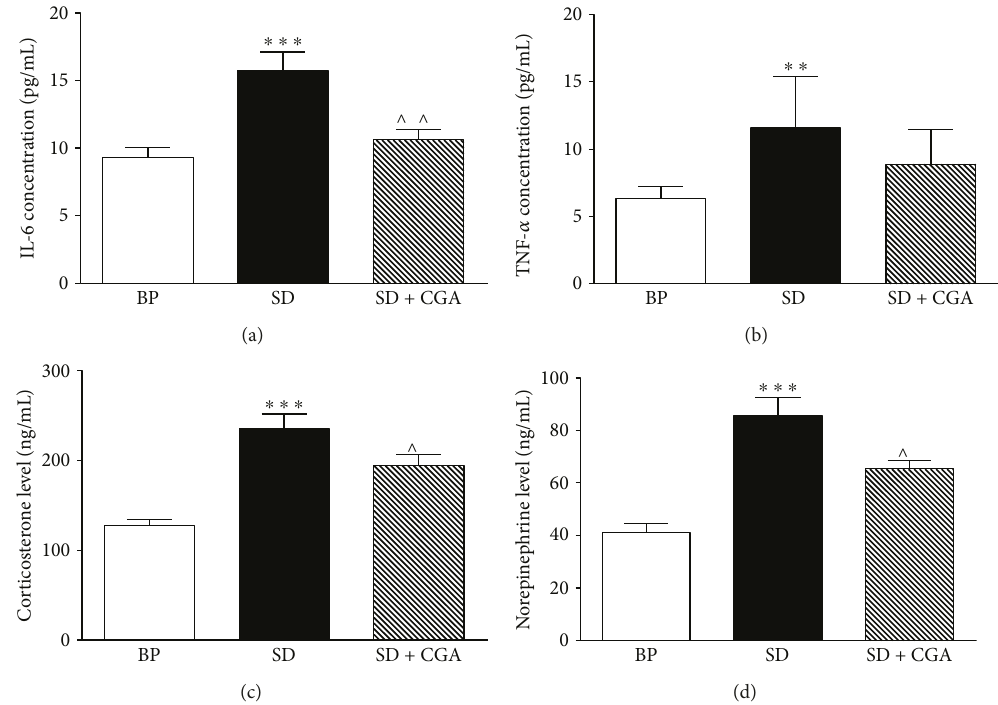
Figure 2: Biochemical index of the three rat group (BP: big platform group, SD: sleep deprivation group, SD+ CGA: SD group with CGA intervention). Data are expressed as mean ± SEM ( n = 6 ). Compared with the BP group, ∗∗∗ P < 0 001 ; compared with the control group, ∗∗ P < 0 01 ; compared with model group, ∧∧ P < 0 01 ; and compared with SD group, ∧ P < 0 05